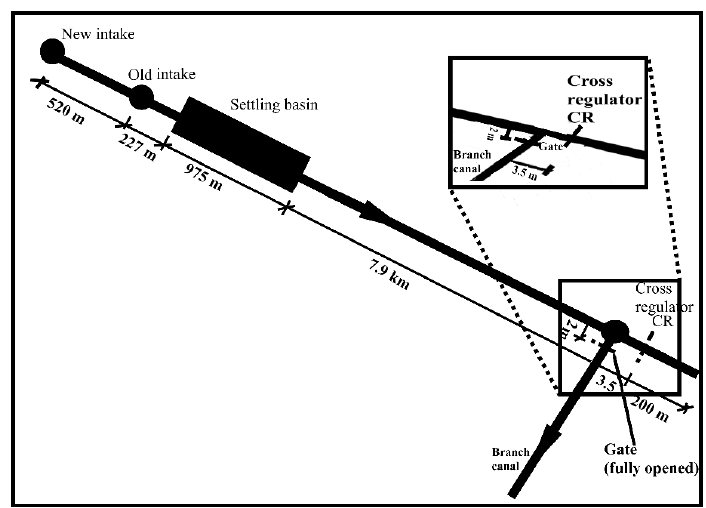
Figure 2. Case study schematization.